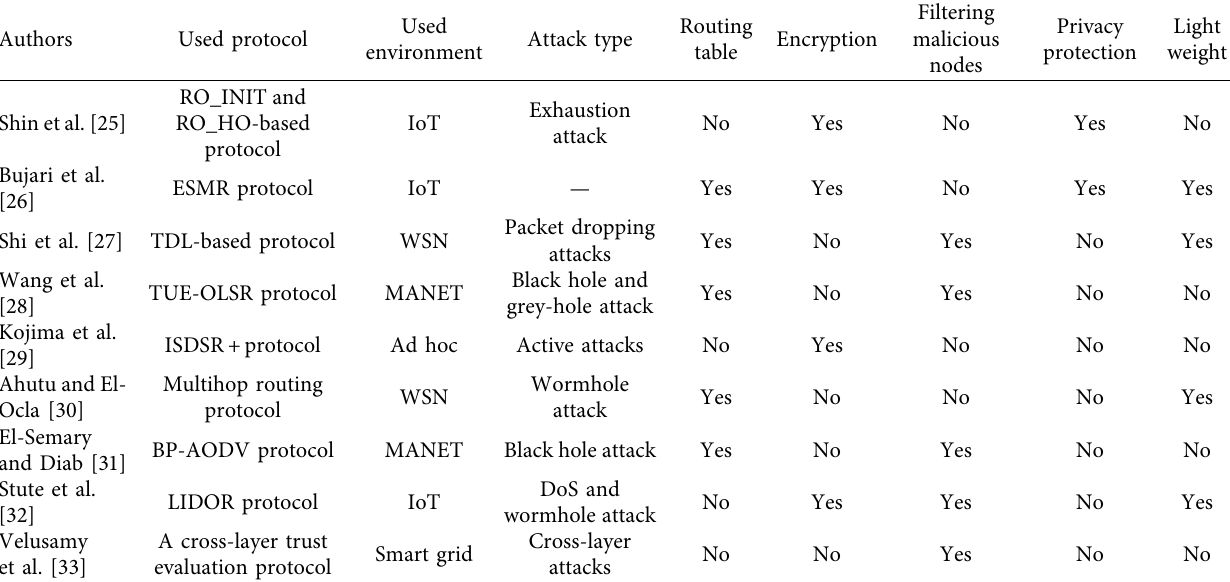
Table 2: Security based routing